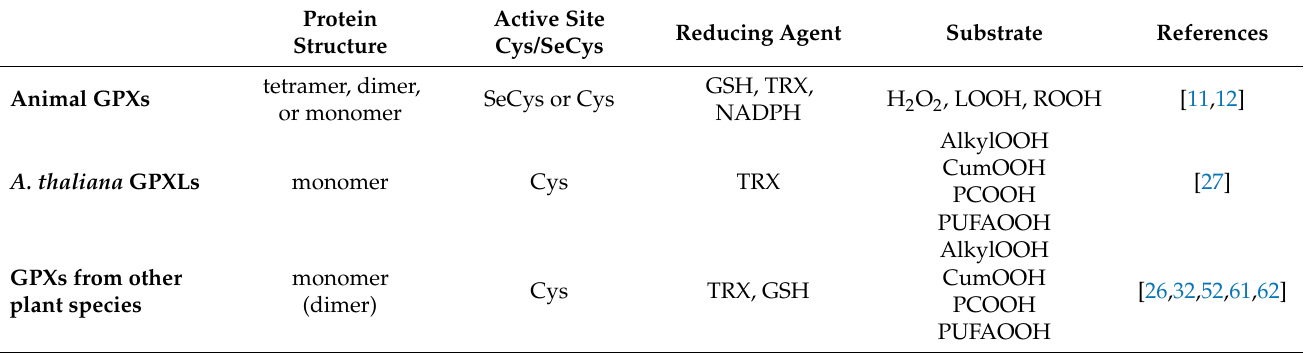
Table 1. Biochemical properties of GPXs. AlkylOOH: alkyl hydroperoxide, CumOOH: cumene hydroperoxide, GSH: reduced glutathione, LOOH: lipid hydroperoxide, PCOOH: phoshatidylcholine hydroperoxide, PUFAOOH: polyunsaturated fatty acids hydroperoxide, ROOH: organic